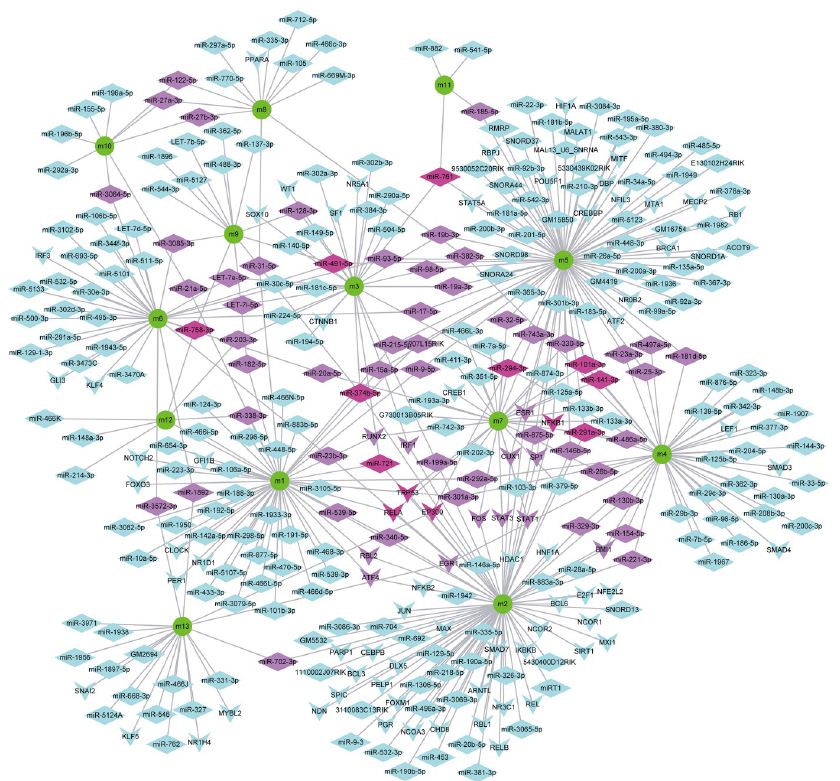
Fig 6. Regulation of ncRNAs and TFs on potential disease-causing modules. The green circle represents the potential disease-causing module, the diamond represents ncRNA, and the arrow shape represents the transcription factor (TF). The color from red to cyan represents the number of modules regulated by regulators (ncRNAs and TFs).